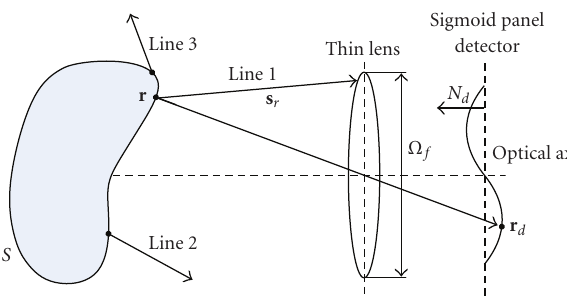
Figure 2: Schematic diagram for non-contact experimental